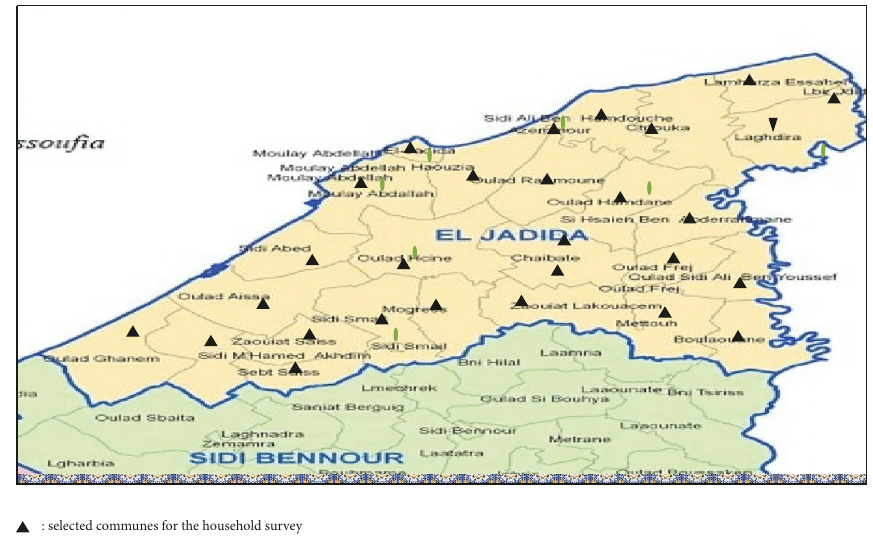
Figure 2: Distribution of sampled places in El Jadida province.